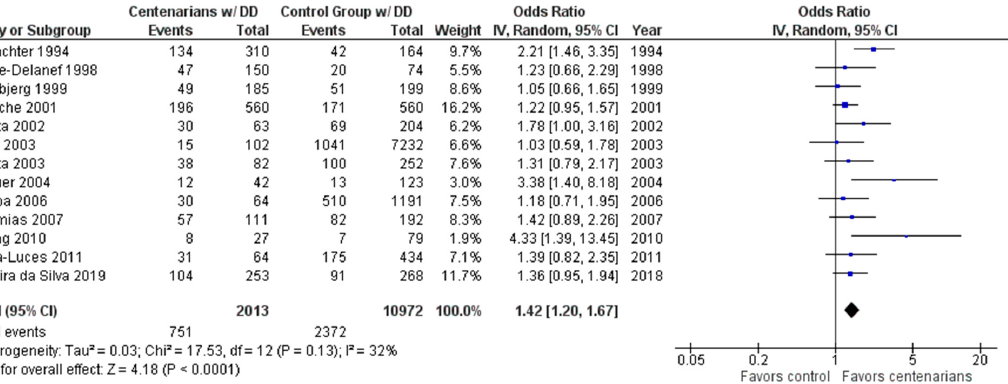
Figure 2. Comparison of DD genotype frequency in centenarians and control groups. The ages of centenarians and control groups are as described in Table 1. The p -value is indicated by P in Figure.